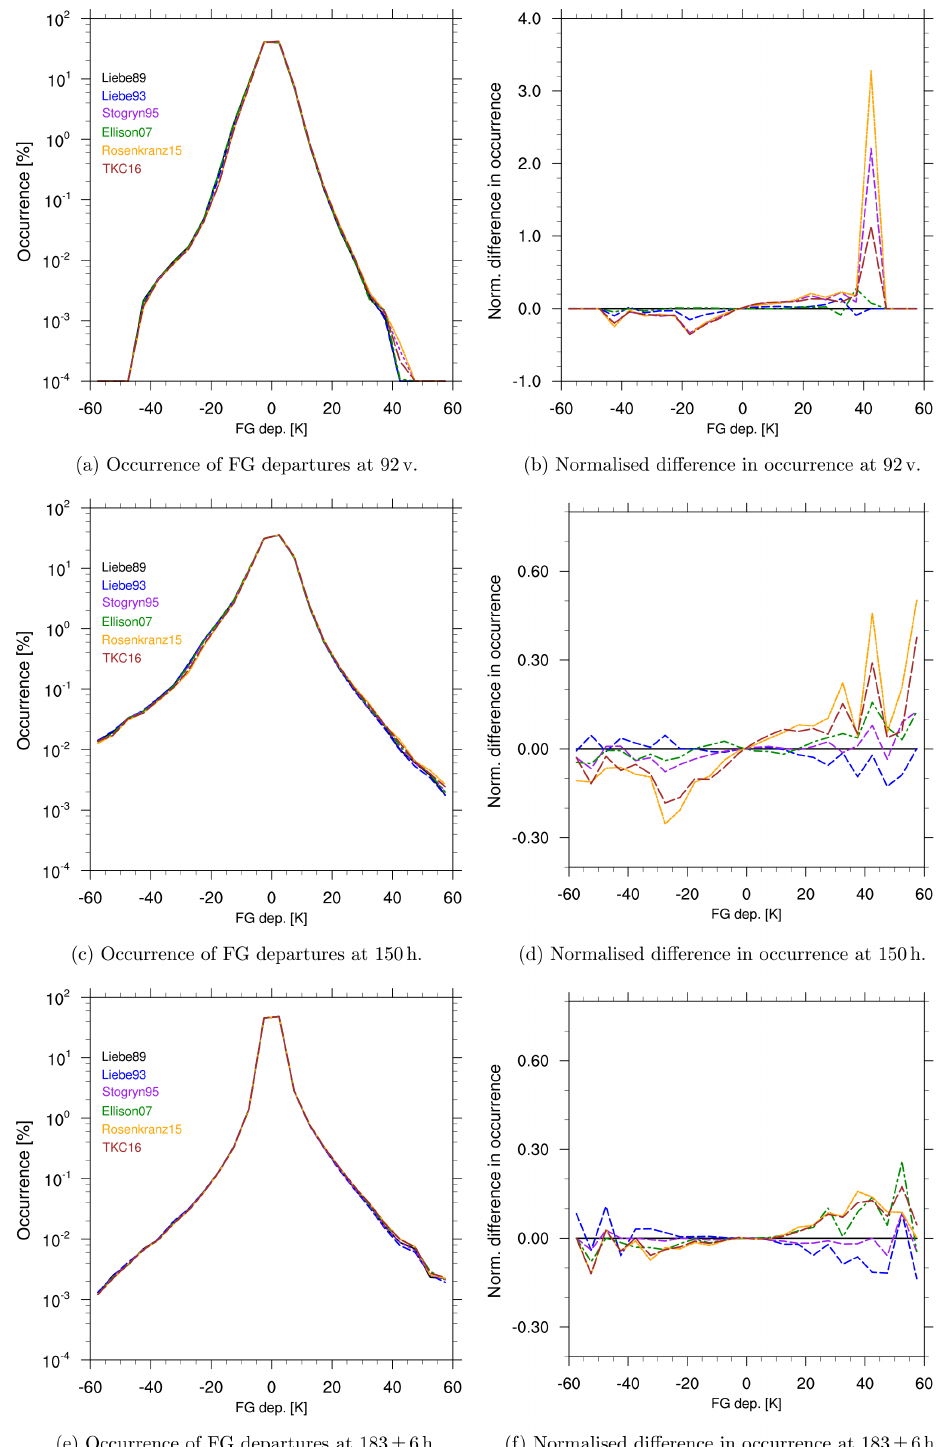
Figure 9. Histograms of FG departure [K] using different liquid water permittivity models with the right panel showing the normalised difference for the newer permittivity models relative to Liebe89. Bin size is 5K. Results cover the time period from 1 to 31 August 2016 for the Southern Hemisphere (20 to 90 ◦ S). Different colours refer to different permittivity models, as shown in the